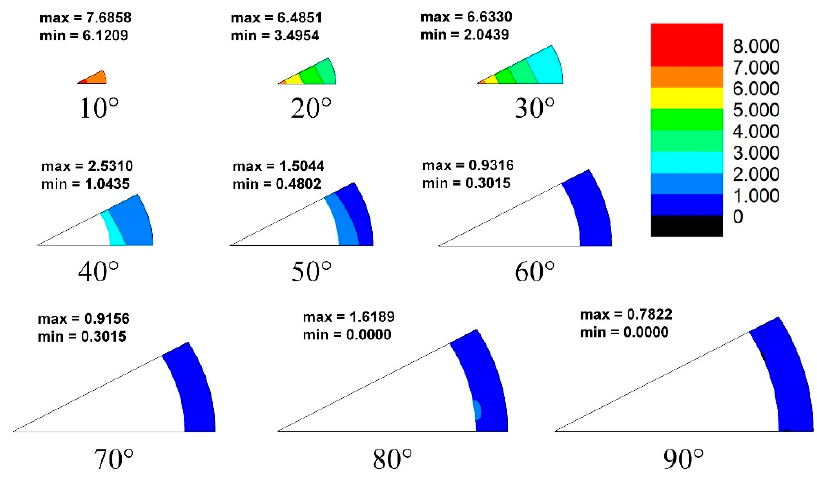
Figure 11. Misorientation distribution map of B–B slip transferred boundaries.